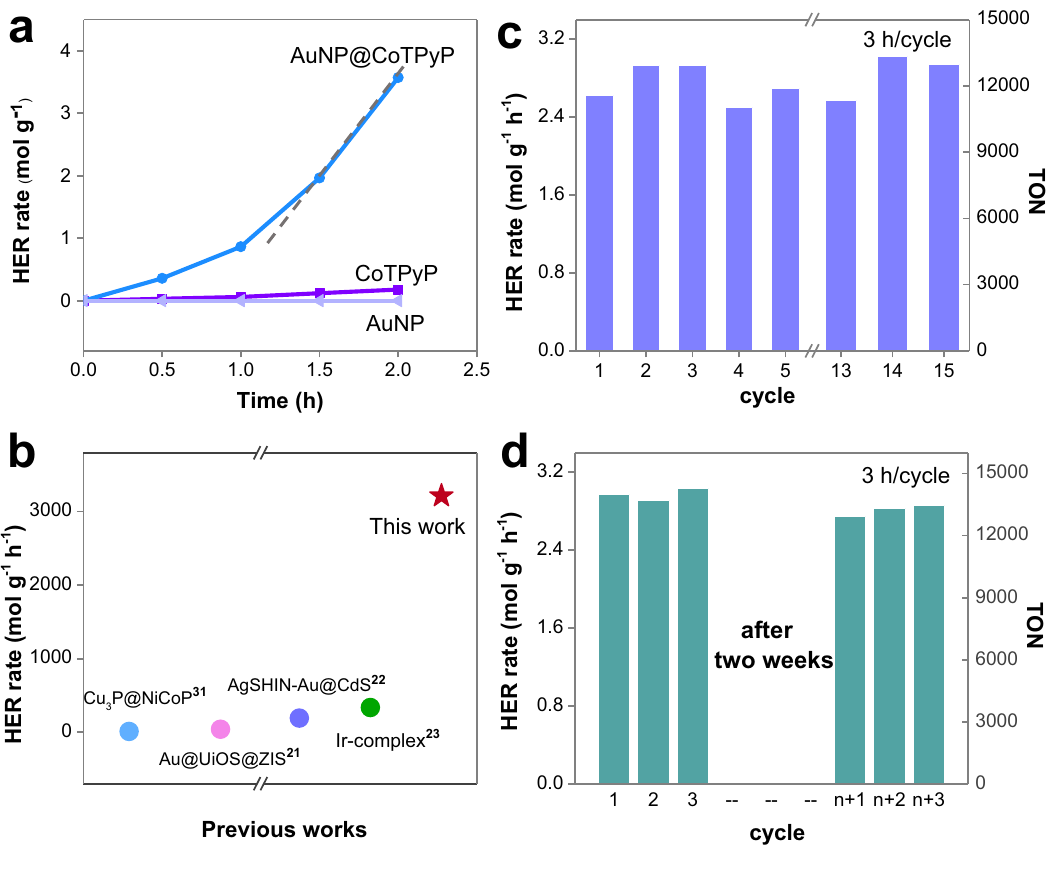
Fig. 2 | Highly ef fi cient and stable HER of the AuNP@CoTPyP nanostructures. a PhotocatalyticHERcurvesofAuNP,CoTPyPandAuNP@CoTPyP. b Photocatalytic HER rates of recently reported photocatalysts. c Photocatalytic HER cycles and